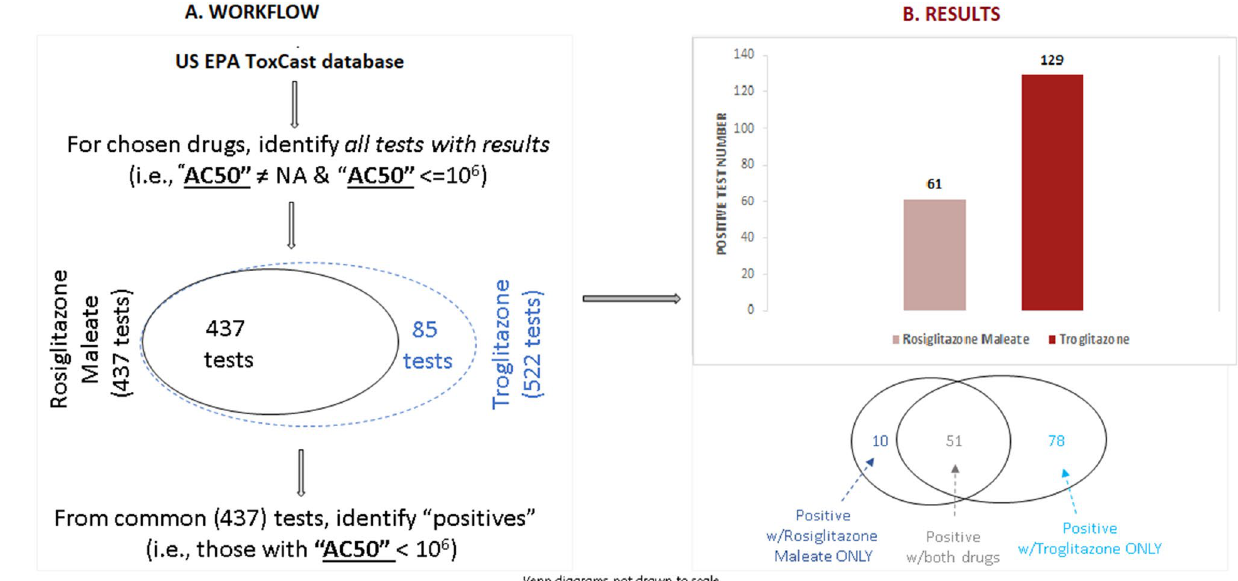
Figure 4. ToxCast database analysis: workflow to identify the tests performed on the two drugs ( A ) and results based on the number of positive tests ( B